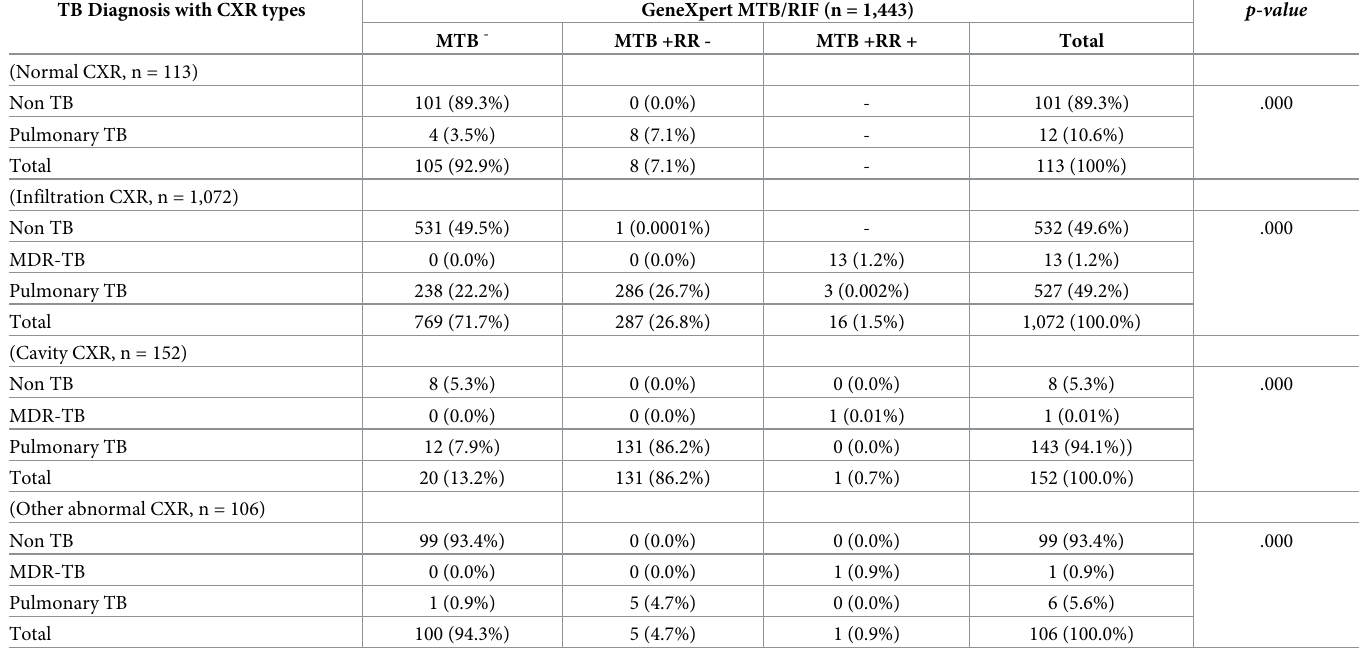
Table 1. Comparisons of TB/MDR-TB diagnosis outcomes between CXR and GeneXpert MTB/RIF among smear negative (n = 1,443). TB Diagnosis with CXR